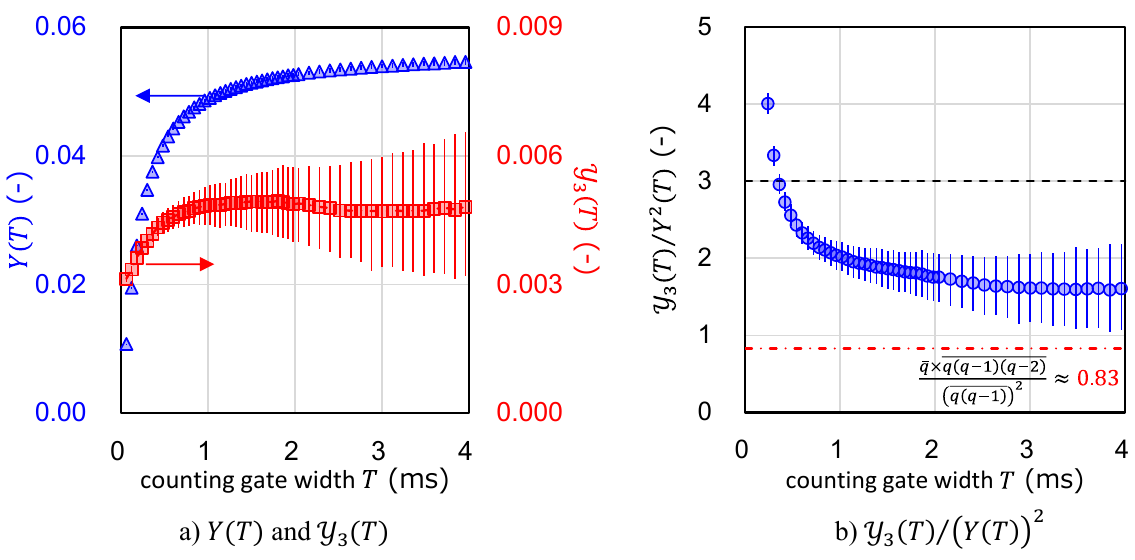
Figure 2. Experimental results of variations in neutron-correlation factors in a non-multiplication system with 252 Cf spontaneous fission